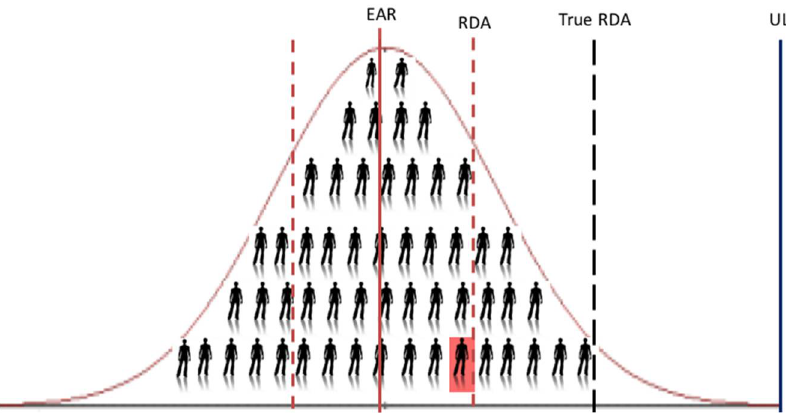
Figure 3. The placement of a hypothetical individual X (highlighted in red) close to the ‘RDA’ (as derived by use of the lower 95th confidence interval on the regression line), but much lower than the ‘True RDA’ is the estimated derived by use of the lower 95% prediction interval from the regression analysis. UL, Tolerable Upper Intake Level for vitamin D.